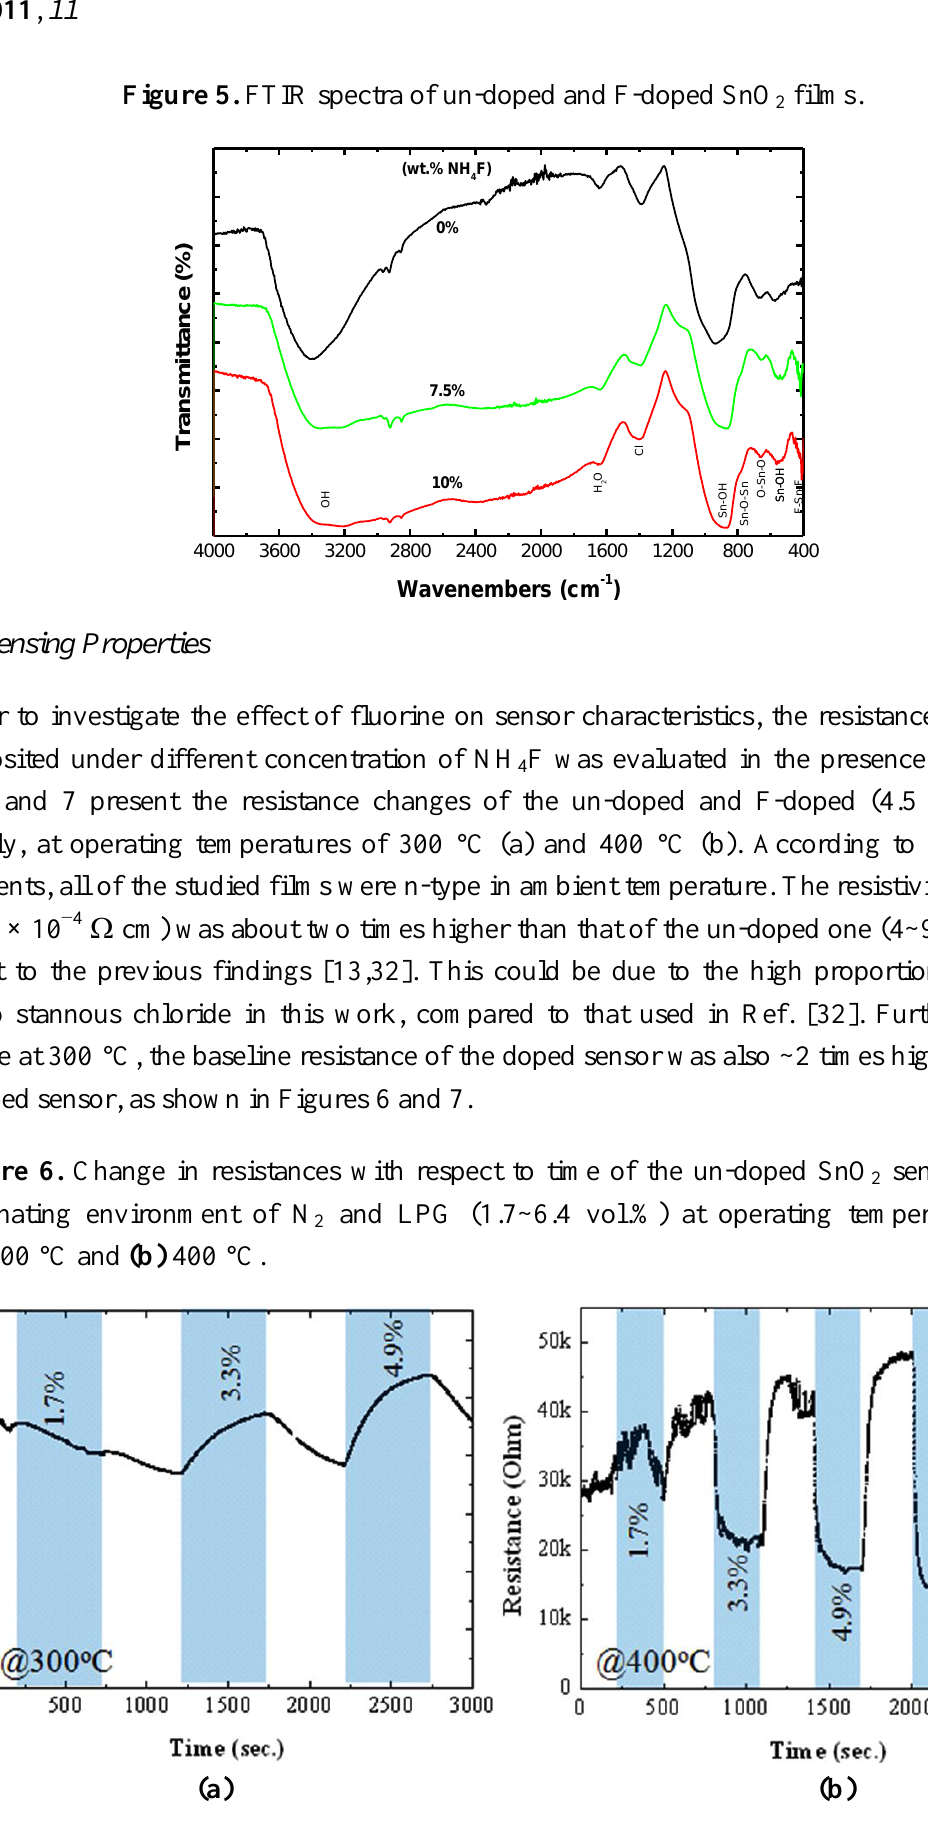
Figure 5. FTIR spectra of un-doped and F-doped SnO